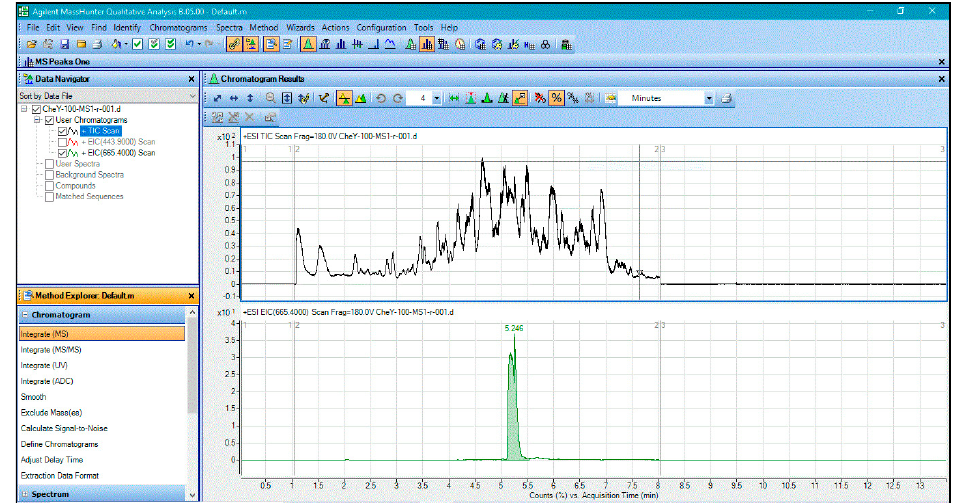
Figure A1. Screenshot of Mass Hunter GUI. MANUAL read in of the peptide m/z values (± 0.1) in Mass Hunter initiated the ex- traction of chromatograms at the entered values (Figure A1), typically with multiple peaks. The peaks corresponding to the sample peptides were retrieved by matching the RTs in the peak list to the RTs recorded for the MS/MS run in the MASCOT file. Tolerance = ± 0.21. Oxidized peak m/z values were ((16/z) × k) Daltons greater than the corresponding m/z values of the unoxidized peaks, where k = oxidation state. P O A 1 (Figure A2).